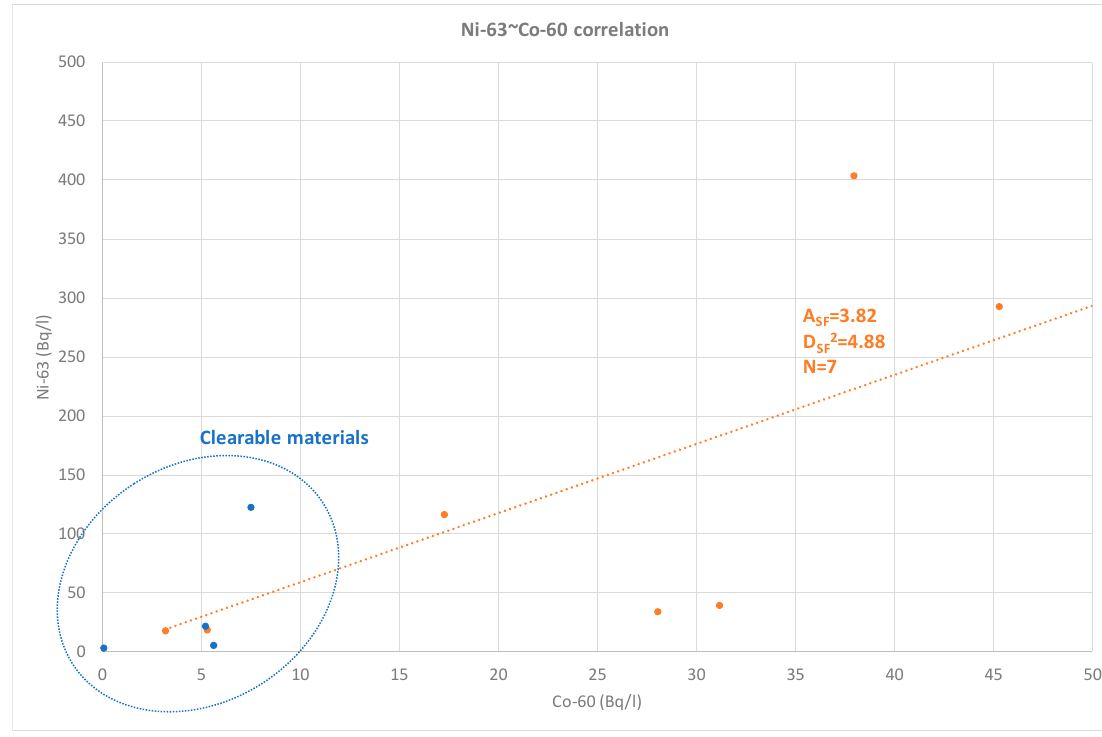
Figure 7. Ni-63~Co-60 correlation present in the Trino “E. Fermi” nuclear power plant’s liquid effluents, in red, and in some clearable materials samples, in blue.